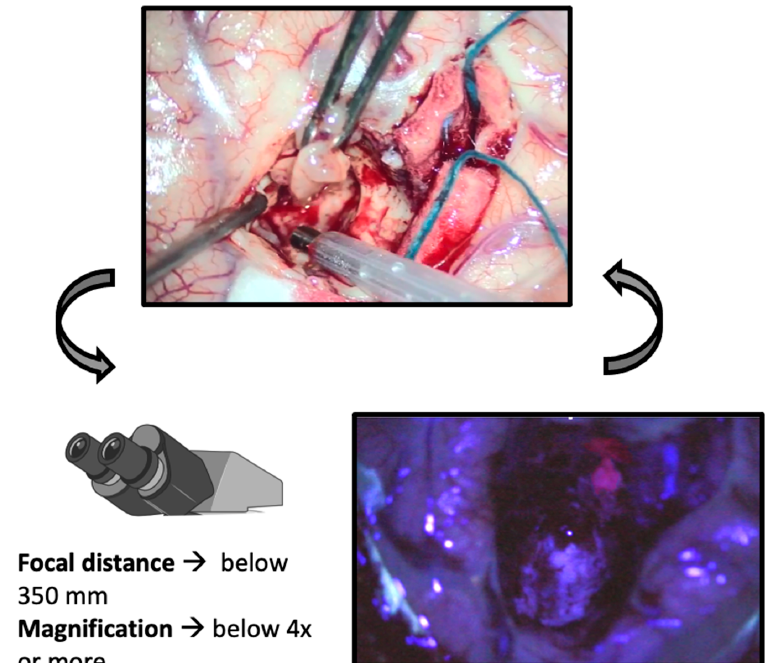
Figure 2. The figure embodies the principles of “check under blue” (bottom right), using an optimal microscope setting (bottom left), and “resect under white” (top). To achieve a satisfying resection, it is necessary to continuously switch from blue to white filter.